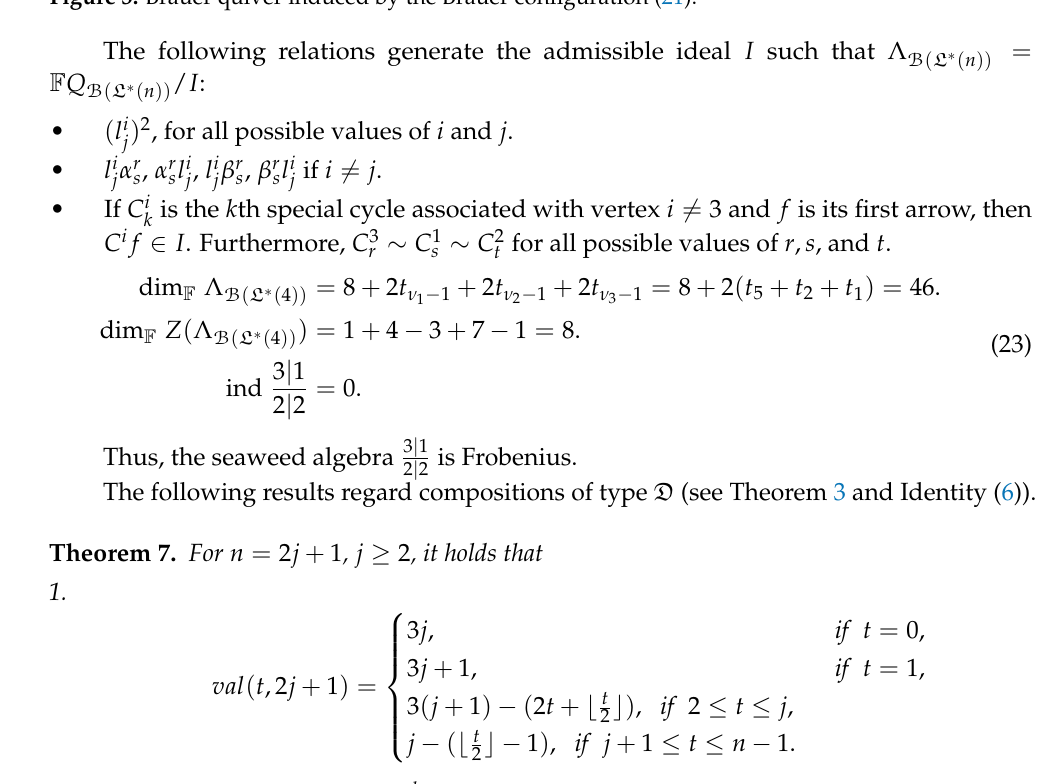
Figure 3. Brauer quiver induced by the Brauer configuration